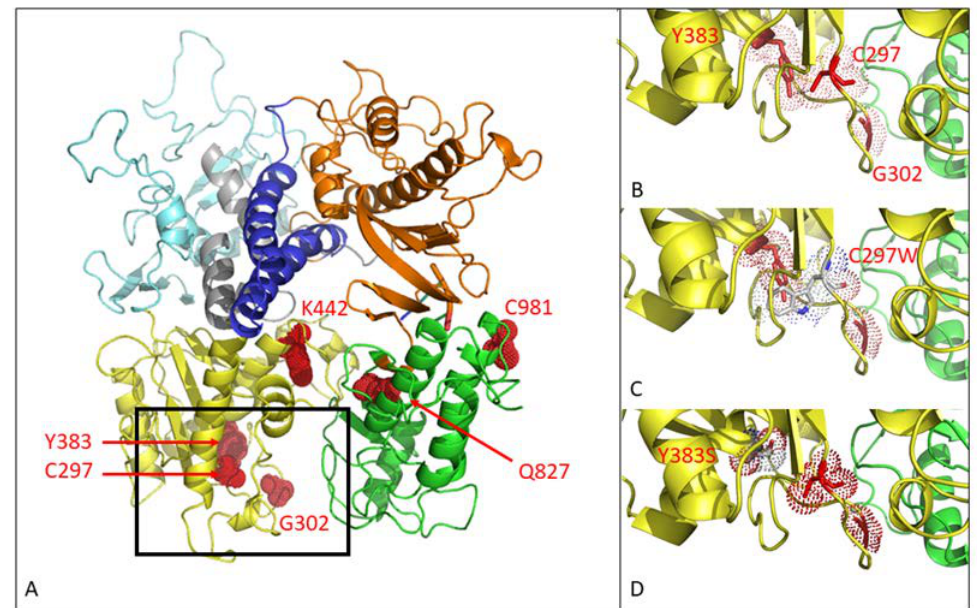
Figure 1. Three-dimensional modeling of mutations in the MHV-68 viral DNA polymerase. ( A ) MHV-68 DNA polymerase consists of 6 domains. Mutations C297W HPMPO-DAPy , G302W PFA , Y383S GCV and K442T PFA map to the 3 ′ –5 ′ exonuclease domain (yellow). Q827R HMP-5azaC and C981Y CDV map to the thumb domain (green). There were no mutations in the other domains (5 ′ –3 ′ exonuclease domain (light blue), NH2 domain (gray), palm (orange), finger (dark blue)). ( B ) Close view of positions C297, G302 and Y383. ( C ) Close view of the amino acid change C297W. ( D ) Close view of the amino acid change Y383S.